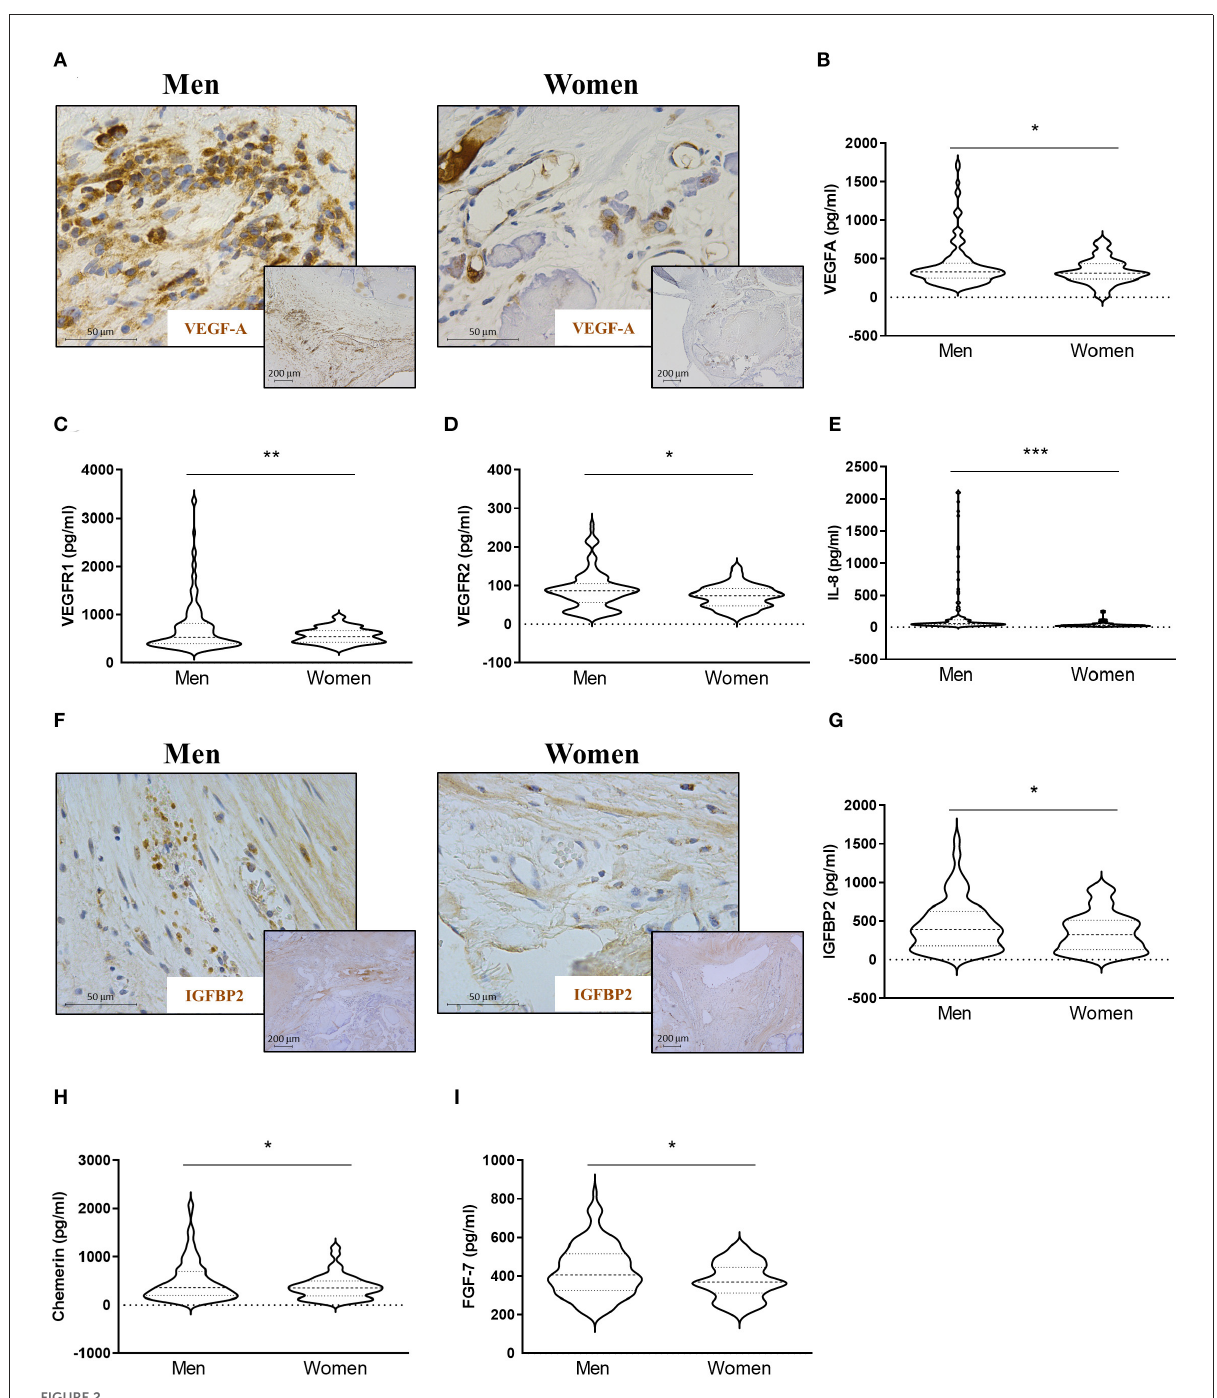
FIGURE2 Sex differences in pro-angiogenic markers in AVs from AS patients. Representative microphotographs of AV sections from AS patients immunostained for VEGFA (A) . Protein expressions of VEGFA (B) , VEGFR1 (C) , VEGFR2 (D) , and IL-8 (E) in tissue homogenates from AVs of AS patients were measured by ELISA. Representative microphotographs are immunostained for IGFBP2 (F) . Protein expressions of IGFBP2 (G) , chemerin (H) , and FGF-7 (I) were measured by ELISA. VEGF: vascular endothelial growth factor; IL, interleukin; IGFBP, insulin-like growth factor binding protein. N = 132 for men and N = 86 for women by ELISA. * p < 0.05 vs. men, ** p < 0.01 vs. men, *** p < 0.001 vs.